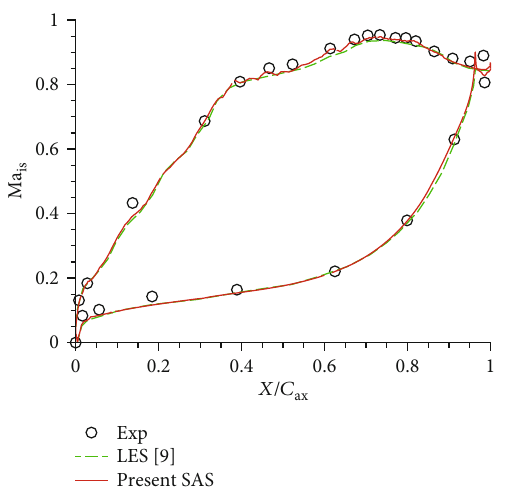
Figure 3: Isentropic Mach number distributions of fl ow condition